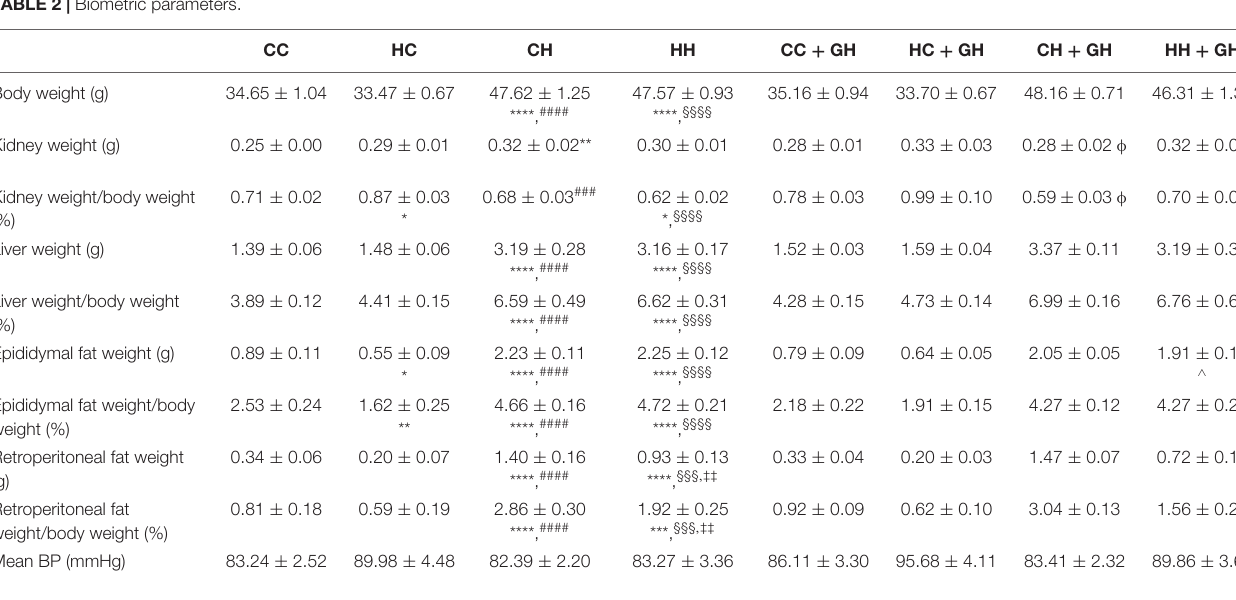
FIGURE 2 | Maternal weight pre-conception and offspring weight at weaning. (A) Weight of dams at the commencement of breeding, (B) weaning weight of male offspring, according to maternal diet and treatment during gestation. Results expressed as mean ± SEM, **** p < 0.0001. TABLE 2 | Biometric